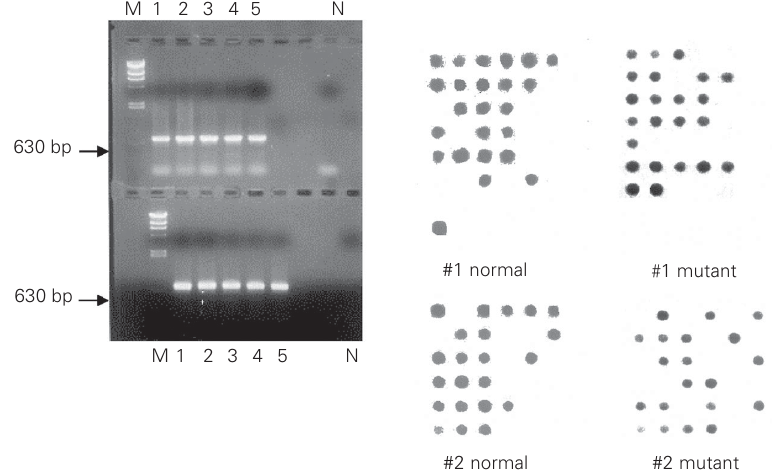
Figure 1. Gamma-globin gene amplification and dot-blot analyses of CAR ß S -haplotype. Sickle cell disease patients, heterozygous for the CAR haplotype, have a positive signal with normal and mutant probes. Homozygous patients have a positive signal only with a mutant probe and negative patients for this haplotype have a signal only with a normal probe. Lanes 1-5 show a 630-bp PCR fragment from the G γ -globin. M = λ Hin dIII marker; N = negative control.